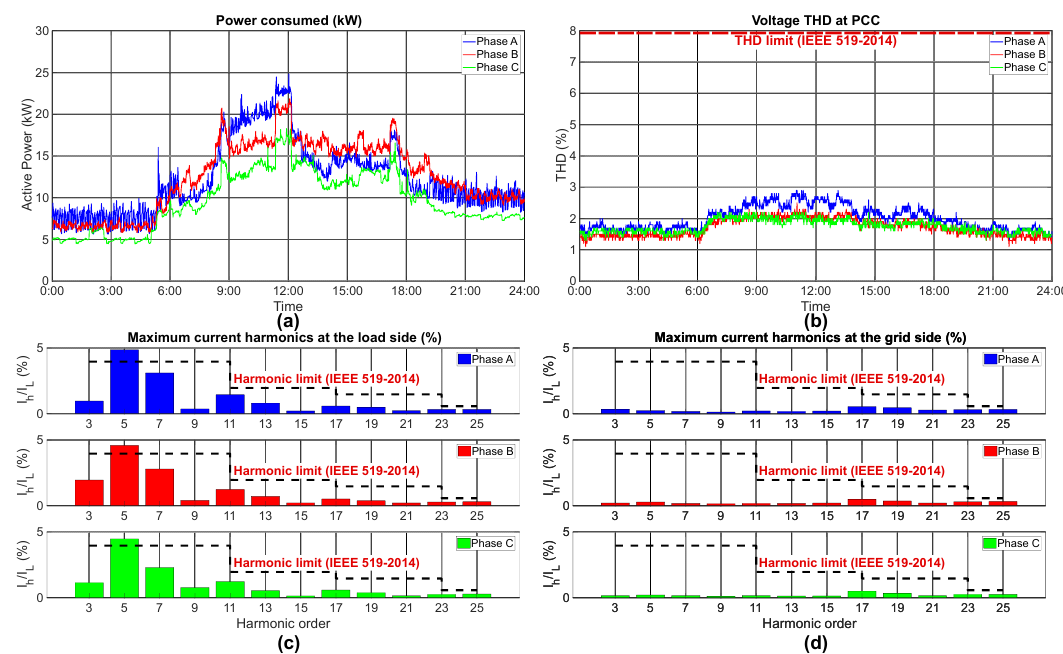
Figure 11. Measurements at the office building: ( a ) active power; ( b ) voltage THD; ( c ) maximum current harmonics consumed by the loads; ( d ) maximum current harmonics at the grid side.